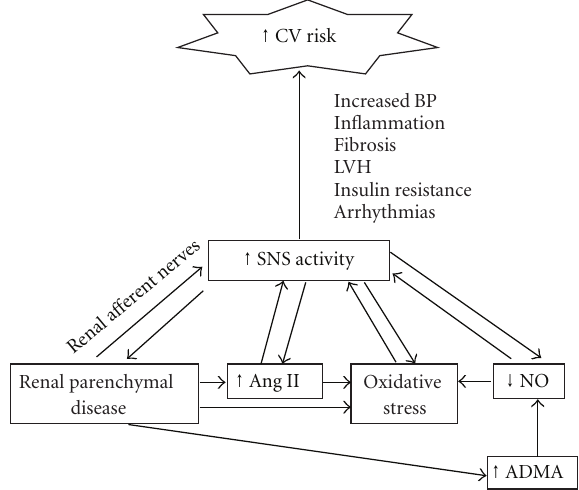
Figure 1: Pathogenesis of sympathetic overactivity in chronic kid- ney Disease factors contributing to increased sympathetic nervous system (SNS) activity in chronic renal failure, leading to increased cardiovascular (CV) risk. ADMA refers to asymmetric dimethy- larginine. NO refers to nitric oxide. Ang II refers to angiotensin II. LVH refers to left ventricular